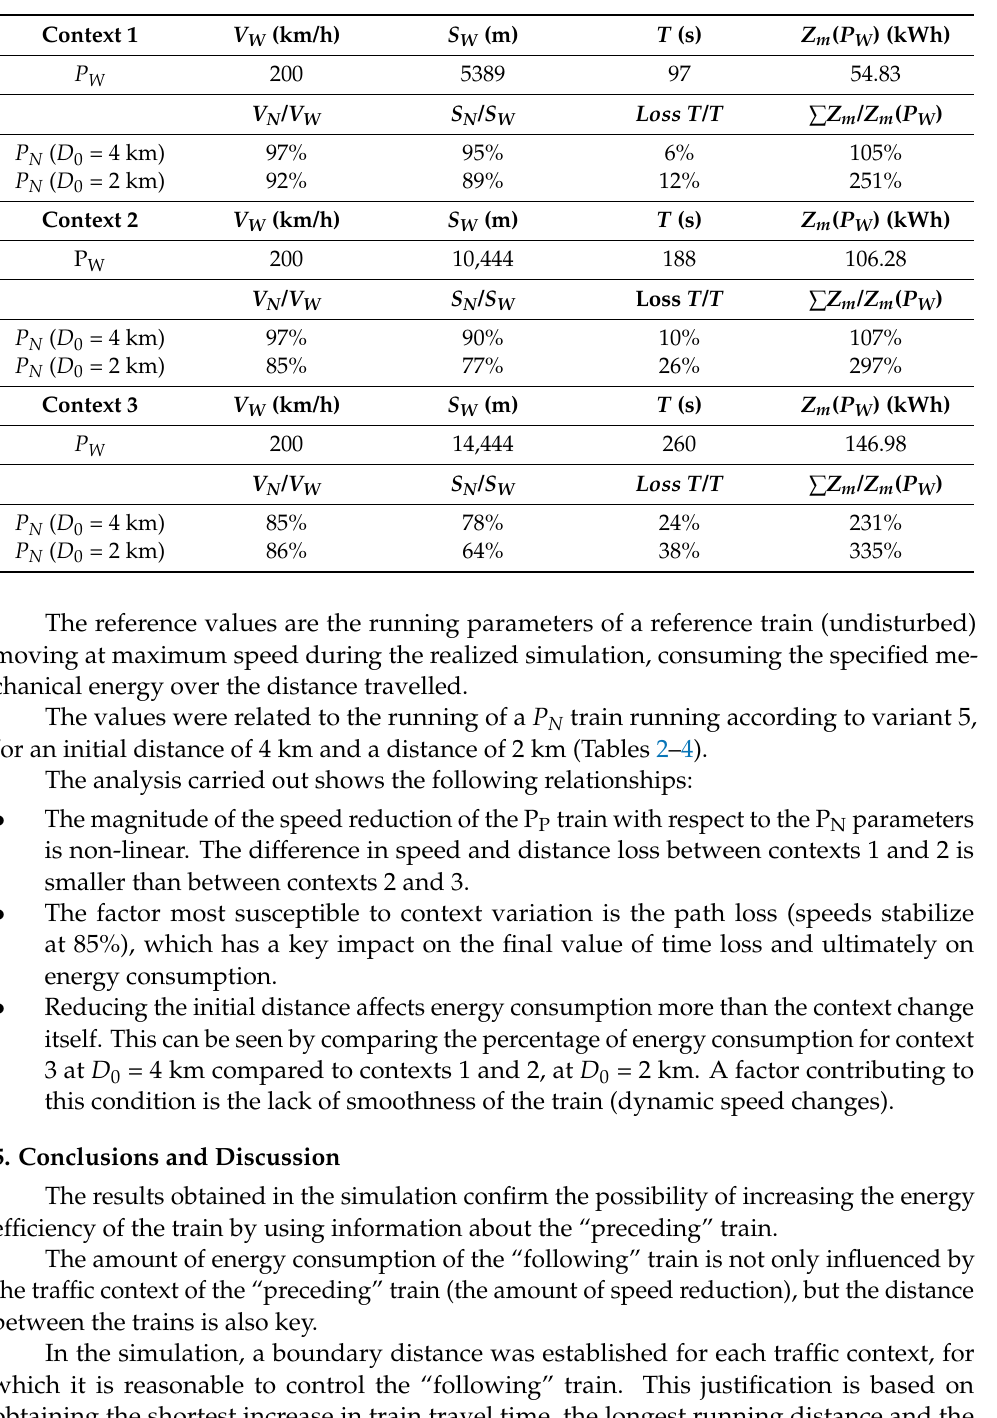
Table 5. Sensitivity analysis of the impact on performance of the different